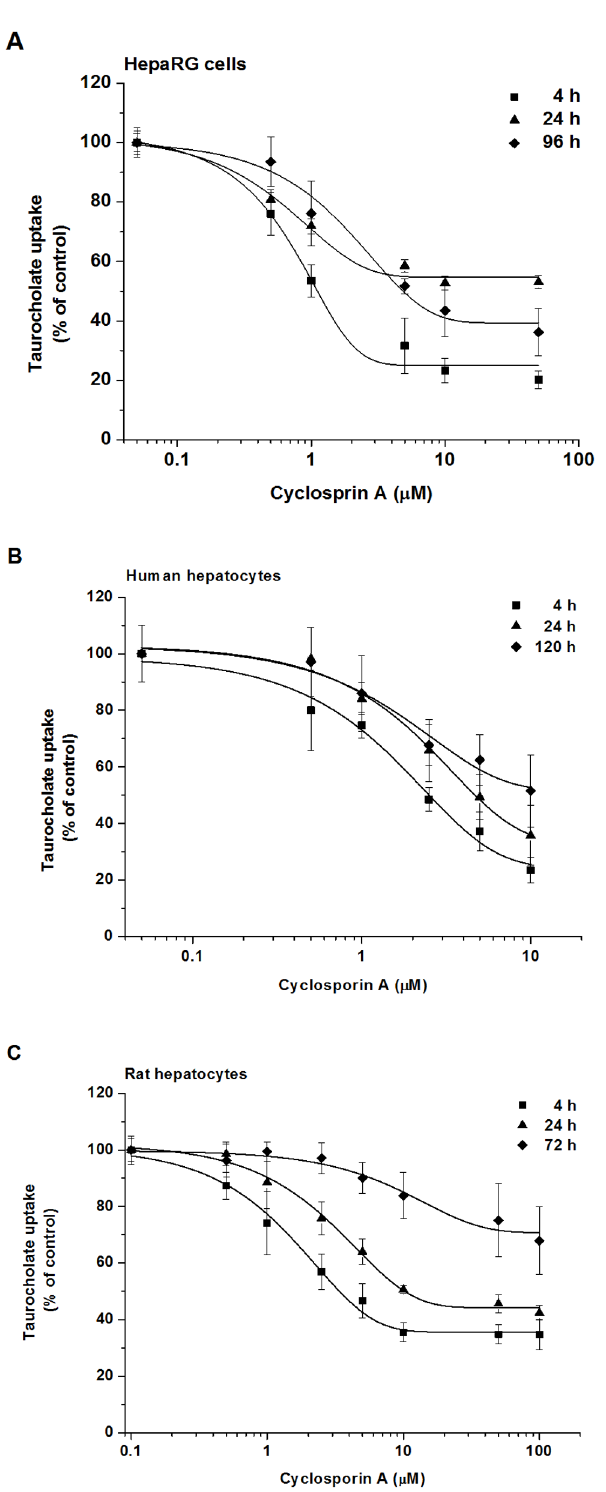
Figure 4. Comparison of the inhibition of TC uptake by cyclosporin A in human and rat hepatocyte cultures and HepaRG cell cultures. (A) HepaRG cells were treated with 1 m M of 3 H- TC for 300 sec at 4, 24 and 96 h after seeding in the presence of cyclosporin A (0.5–50 m M), or the vehicle, respectively. (B) Human and (C) rat hepatocytes were treated with 1 m M of 3 H-TC for 30 sec at 4, 24 and 120 h (human) or 4, 24 and 72 h (rat) after seeding in the presence of cyclosporin A (0.5–10 m M or 0.5–100 m M), or the vehicle,